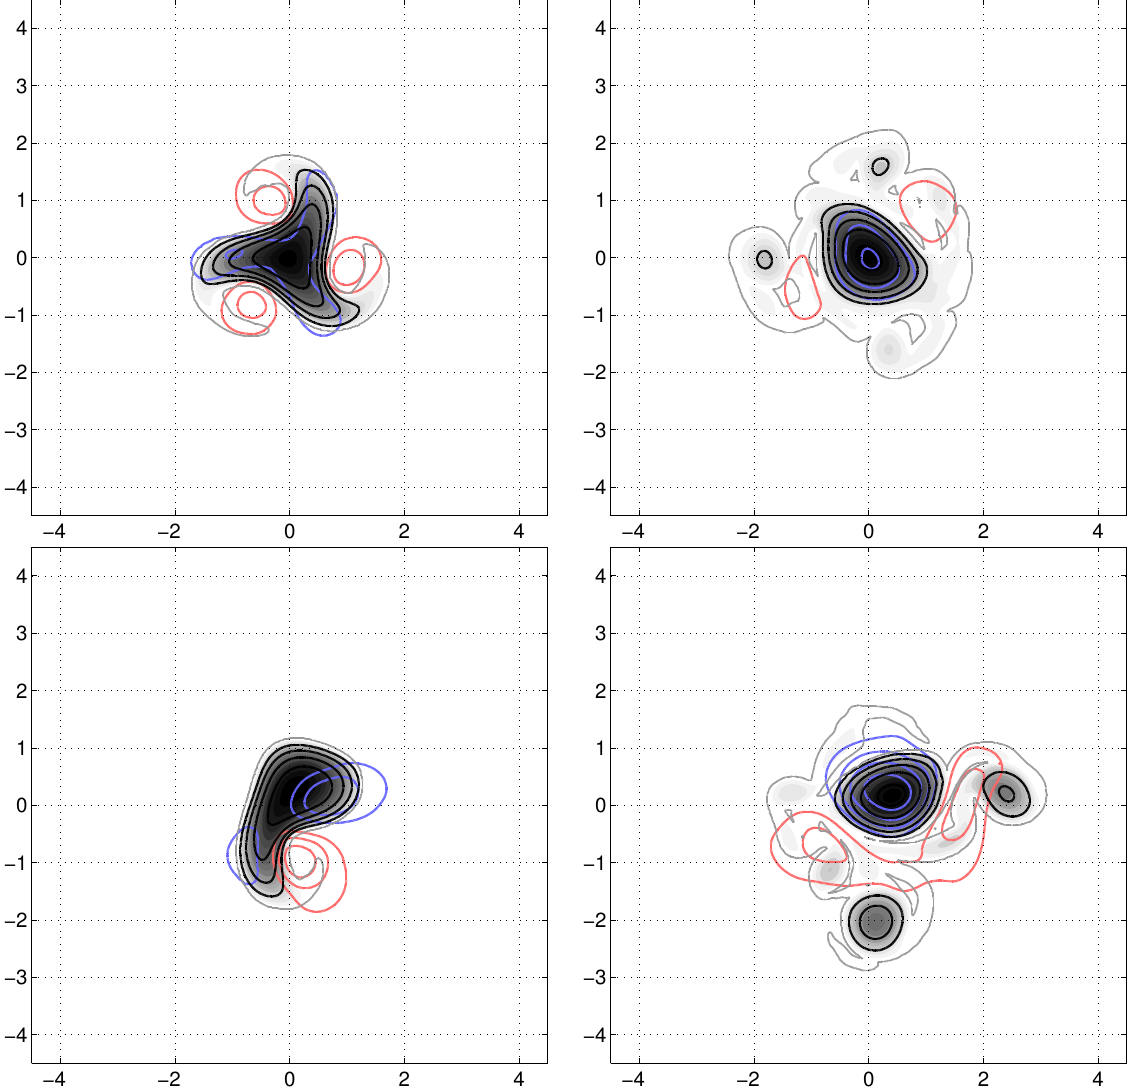
Figure 8. Snapshots of thickness (grey shading, black for h 1 = δ = 0.2) and pressure in the upper layer (black contour at intervals of 4 × 10 − 4 starting from 0) and lower layer (positive in blue, negative in red, at intervals of 10 − 4 ) for the simulations initialized with m = 2 perturbation (first row), m = 3 perturbation (second row) and several wavenumbers (last row) at t = 130 f − 1 (left column) ant 260 f − 1 (right panel), corresponding roughly to 5 and 10 inverse growth rate. Initial vortex profile parameters: Q 1 = 12, δ =